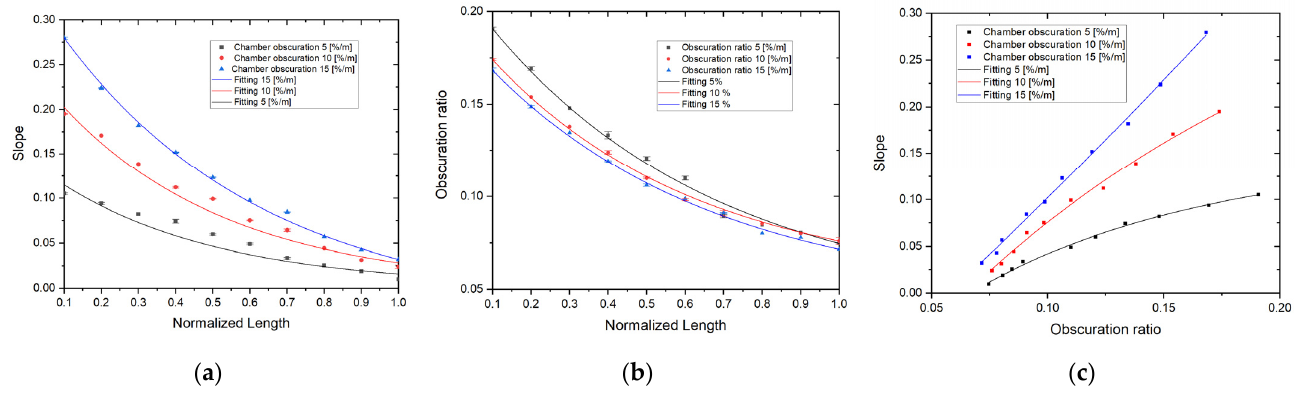
Figure 7. ( a ) The slope and normalized length correlation; ( b ) The obscuration ratio and normalized length correlation; ( c ) The slope and obscuration ratio